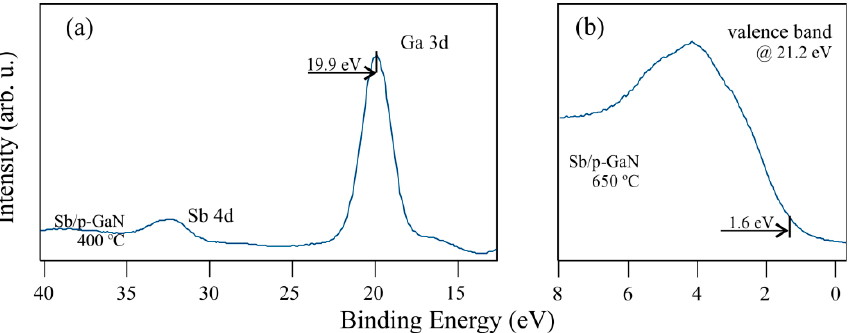
Figure 36. XPS spectra of ( a ) Ga-3d, Sb-3d, and ( b ) UPS spectra of the valence band for an annealed Sb-film-covered GaN(0001) surface at 400 ◦ C. Amount of residual arsenic is ~0.7 ML. Data previously published in [57].